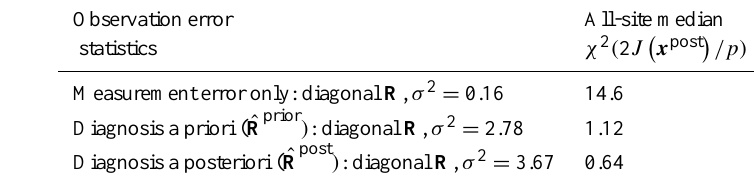
Table 1. Chi-square test after